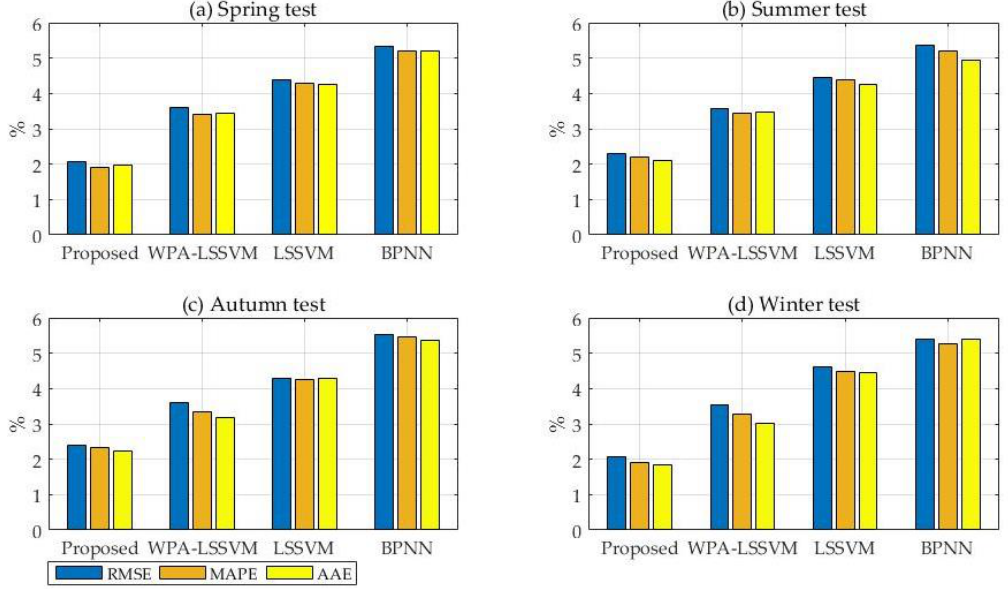
Figure 12. RMSE, MAPE and AAE of the forecasting results (II): ( a ) Spring test; ( b ) Summer test; ( c ) Autumn test; ( d ) Winter test.